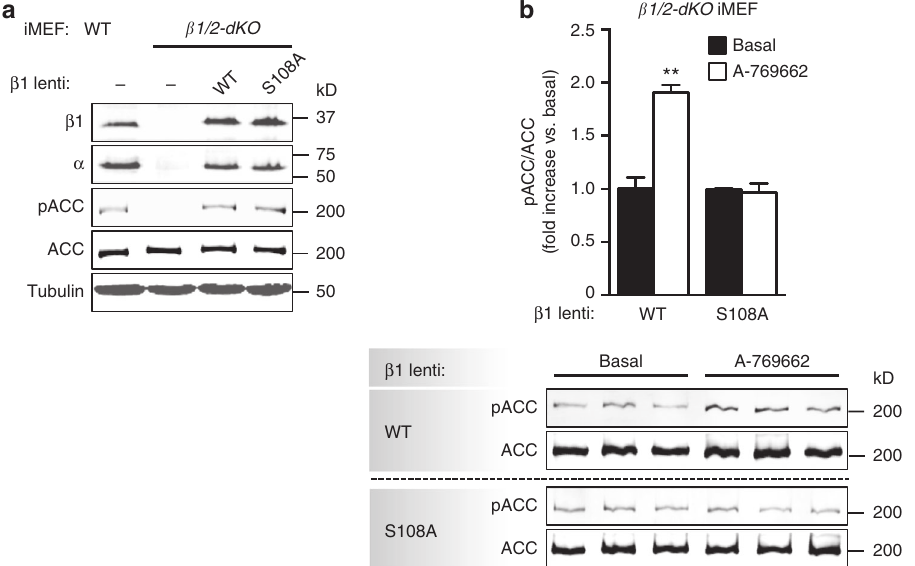
Fig. 1 A-769662 activation of cellular AMPK signaling is dependent on β 1-pSer108. a Reconstitution of basal AMPK signaling in AMPK β 1/2 double knockout ( β 1/2-dKO ) iMEFs by lentiviral transduction of AMPK β 1 WT or S108A mutant. b Immunoblots for pACC from β 1/2-dKO iMEFs-expressing β 1 WT or S108A mutant, stimulated with 20 μ M A-769662 for 90 min. n = 3. Error bars , mean pACC fold change relative to basal ± s.e.m. Statistical analysis was performed using unpaired two-tailed Student ’ s t -test. ** P < 0.01 indicates signi fi cant increase in pACC compared to